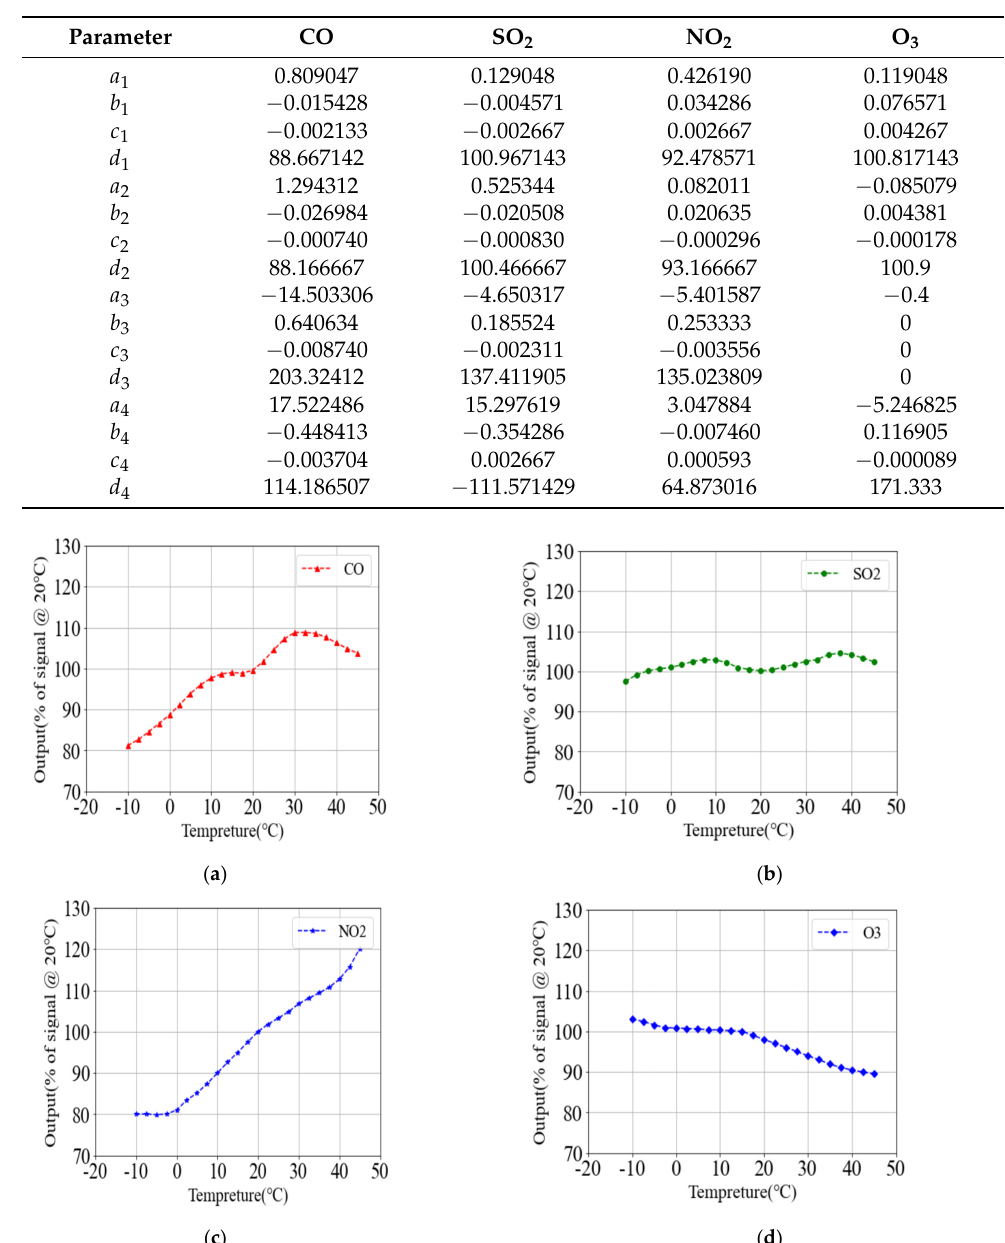
Table 5. Temperature compensation parameters.